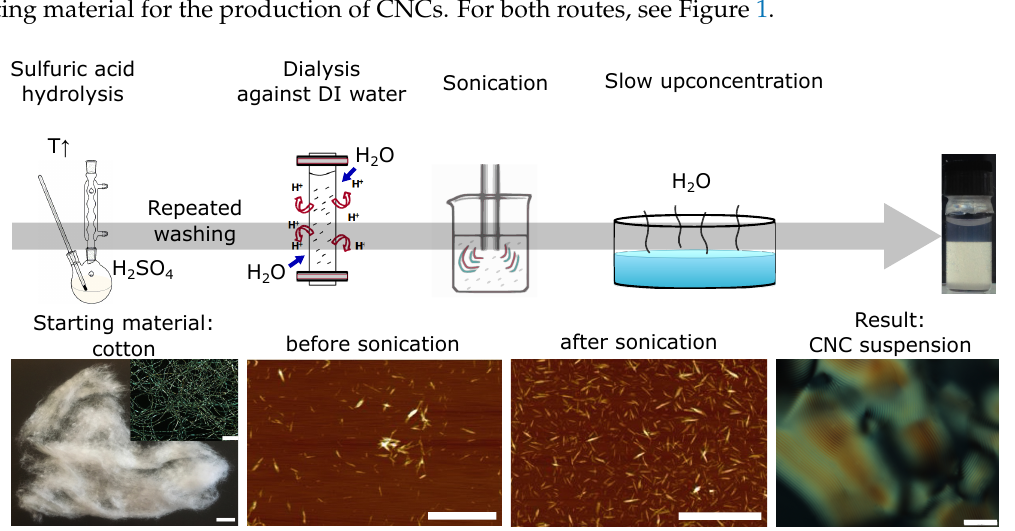
Figure 1. Upper line: simplified schematic of a typical CNC production scheme, here starting from a slurry of sulfuric acid and cotton; CNF or bacterial cellulose can be used instead. The sulfuric acid attacks the weaker regions in the cellulose fibrils and removes them, while at the same time providing the remaining CNCs with charged − SO − groups on their surface. The hydrolysis is terminated by 3 dilution with excess water and the remaining acid is removed by repeated washing and dialysis. The highly diluted product is then ultra-sonicated to realize well dispersed CNCs. In a final step the diluted suspension is often concentrated (sometimes under reduced pressure) to give a maximum mass fraction of CNCs that still forms a stable suspension in water. This stock suspension can then be diluted again to achieve lower mass fractions. Lower line, from left to right: cotton as example of an untreated cellulose source (macroscopic and microscopic, as imaged by polarized light microscopy, scale bars are 1 cm and 500 µ m, respectively); AFM images of CNCs before and after sonication (scale bar 1 µ m), produced by sulfuric acid hydrolysis, with H + counter ions, both samples prepared by depositing a suspension with a mass fraction of w = 0.002 wt.% on the substrate used for imaging; polarized optical micrograph of the cholesteric phase formed by a CNC suspension (scale bar 100 µ